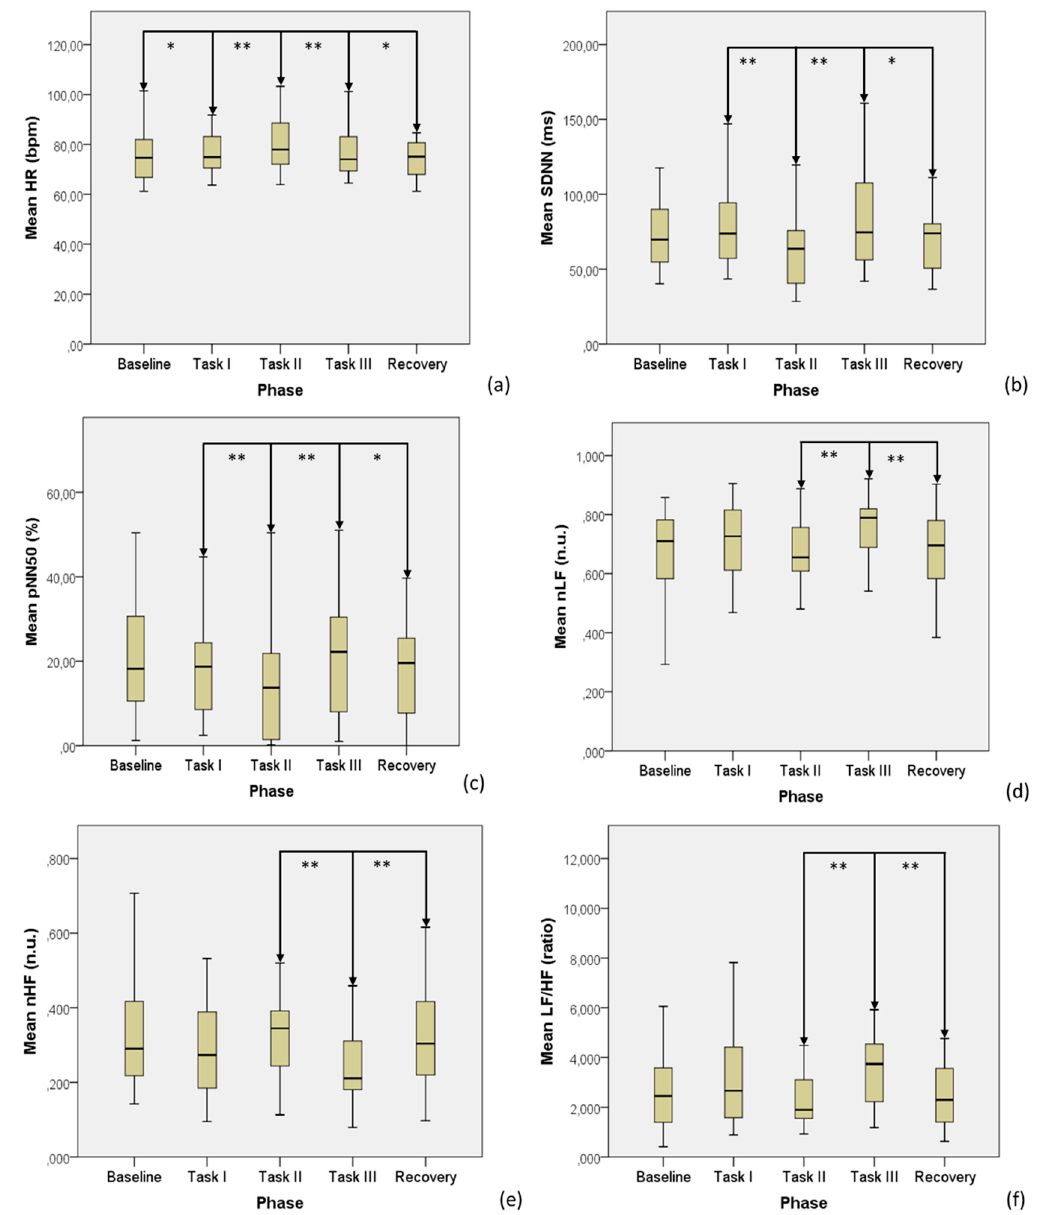
Figure 1. Significant ECG data across the test phases: ( a ) HR, ( b ) SDNN, ( c ) pNN50, ( d ) nLF, ( e ) nHF, ( f ) LF/HF. *: p < 0.05, **: p < 0.01. The GSR tonic trend is otherwise displayed in Figure 2.